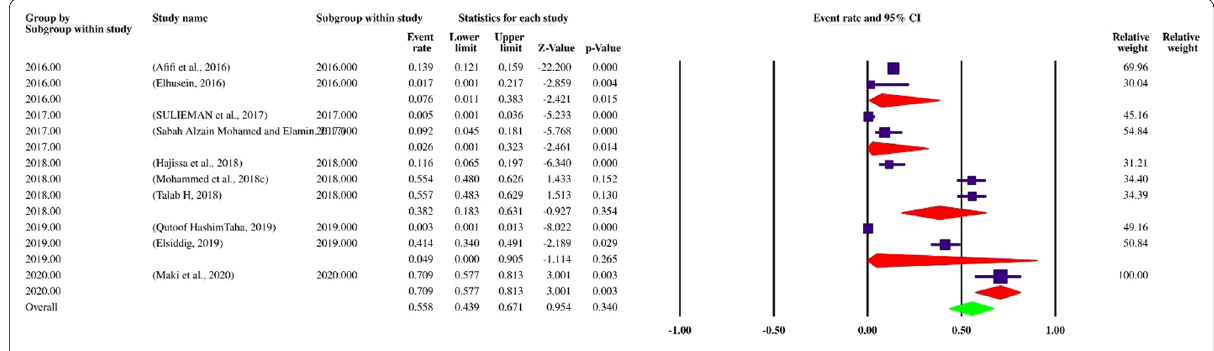
Fig. 4 Forest plot of year-based prevalence in Sudan